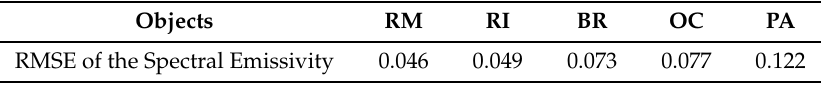
Figure 5. ( a ) Comparison of the emissivity spectral distribution of polished aluminum plate measured with two different instruments at 8–14 µm; ( b ) comparison of the emissivity spectral distribution of copper plate measured with two different instruments at 8–14 µm; ( c ) comparison of the emissivity spectral distribution of iron plate measured with two different instruments at 8–14 µm; ( d ) comparison of the emissivity spectral distribution of marble plate (rough surface) measured with two different instruments at 8–14 µm; and ( e ) comparison of the emissivity spectral distribution of rubber sheet measured with two different instruments at 8–14 µm. Table 4. Comparison of emissivity from two approaches. Table 4. Comparison of emissivity from two